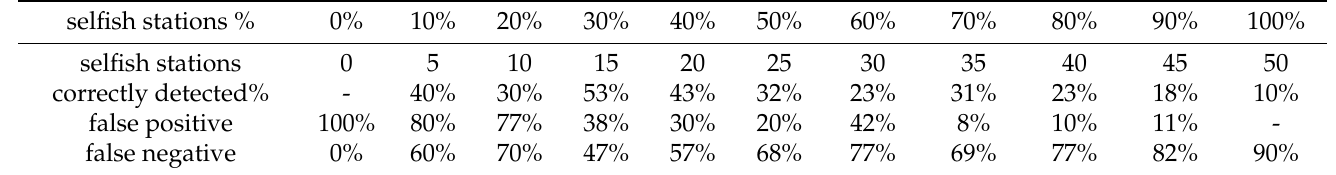
Table 6. Deviation detection mechanism for 50 stations and 2 slots in TCP firmware scenario.